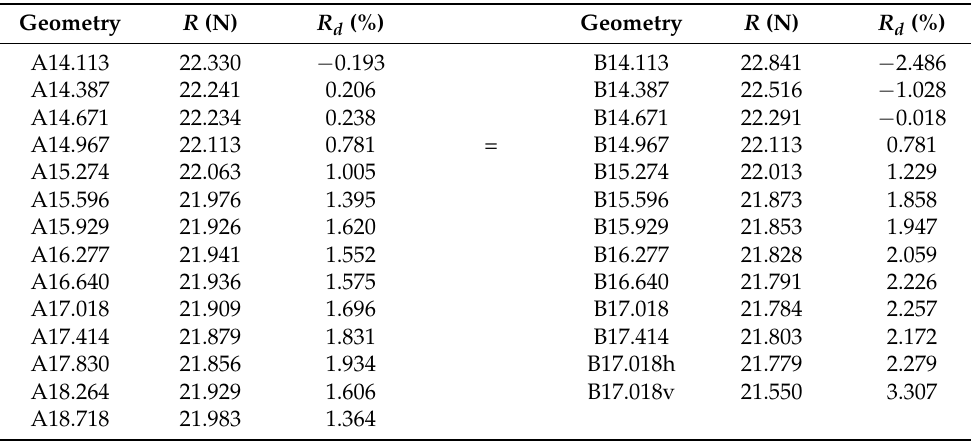
Table 4. Resistance results and reduction R d for Type A and B sonar domes.